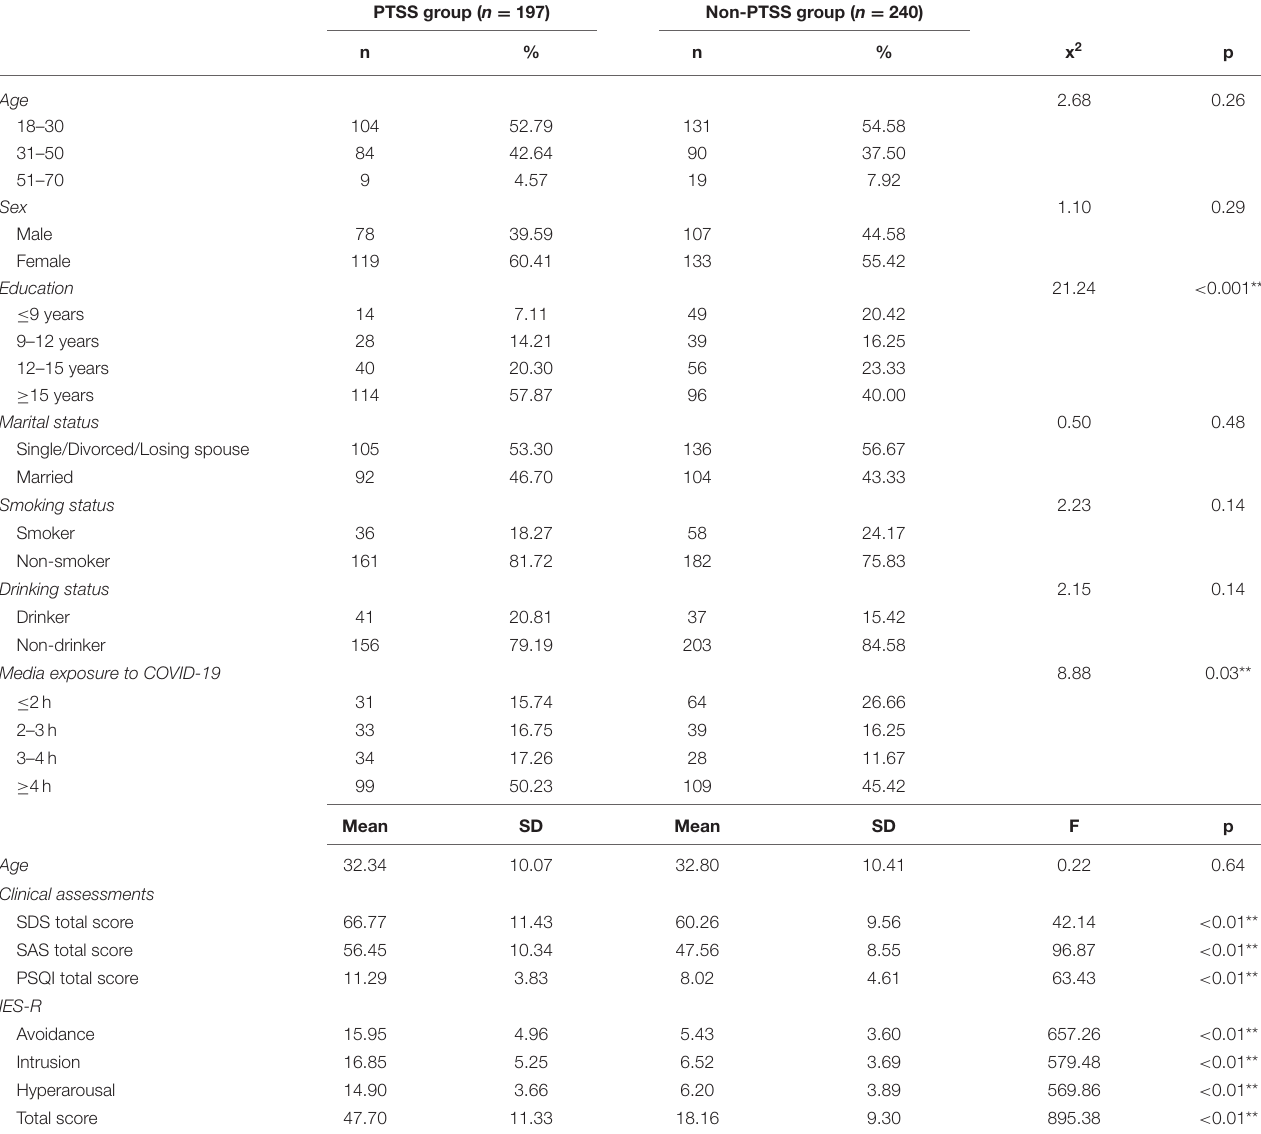
TABLE 2 | Social demography and clinical characteristics of depressed subjects with PTSS and without-PTSS (IES-R ≥ 33) (x 2 and